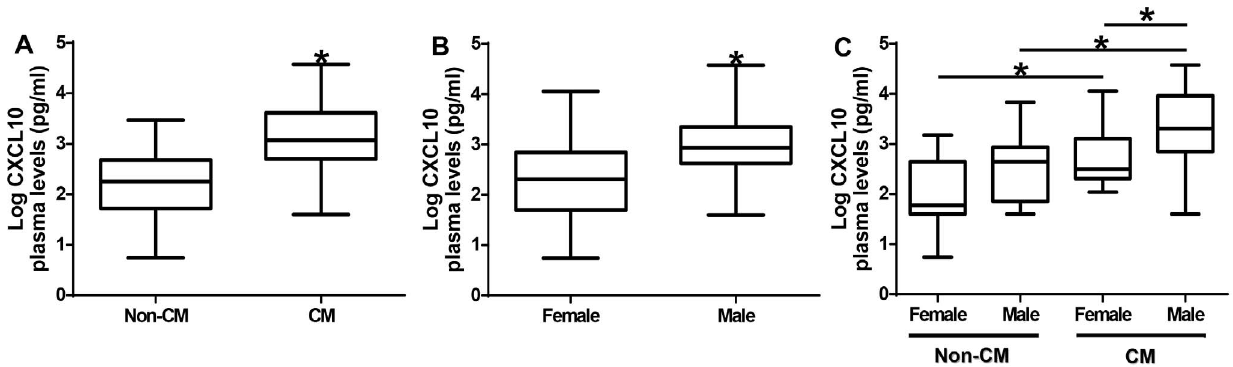
Figure 1. Plasma levels of CXCL10 protein among the study group. (A) Association of plasma CXCL10 protein levels with CM. Cerebral malaria patients have significantly higher plasma CXCL10 levels than non-CM patients (p , 0.0001). (B) Association of plasma CXCL10 protein levels with gender. Males have significantly higher plasma CXCL10 levels than females (p , 0.0001). (C) Association of plasma CXCL10 protein levels with CM stratified by gender. Both males and females in the CM group have significantly higher plasma CXCL10 levels than the corresponding gender in the non-CM group (p , 0.05). Box plot represent log-transformed medians with 25 th and 75 th percentiles, bars for 10 th and 90 th percentiles. Significant differences of CXCL10 median levels between the groups were determined by Mann-Whitney U test or Kruskal Wallis test with Dunn’s multiple